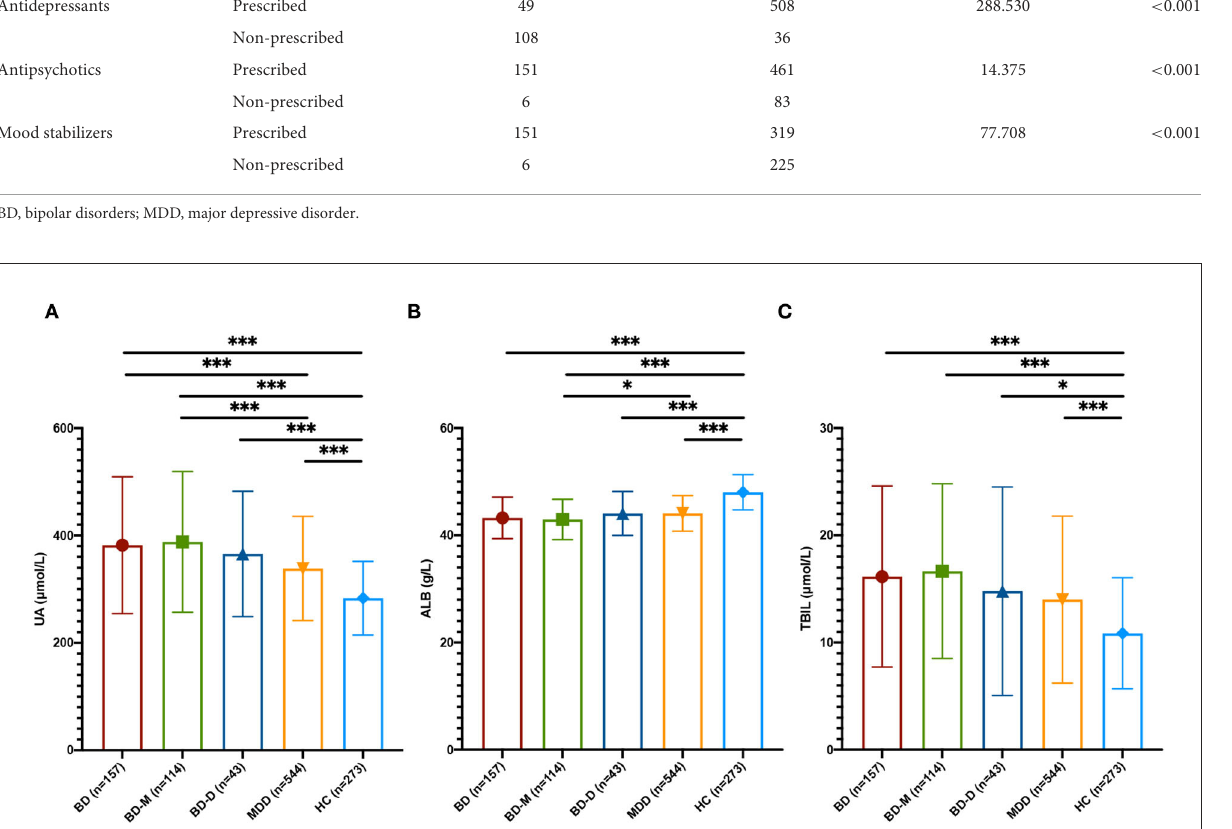
was 0.990 (accuracy = 0.909, 95% CI = 0.843–0.954).